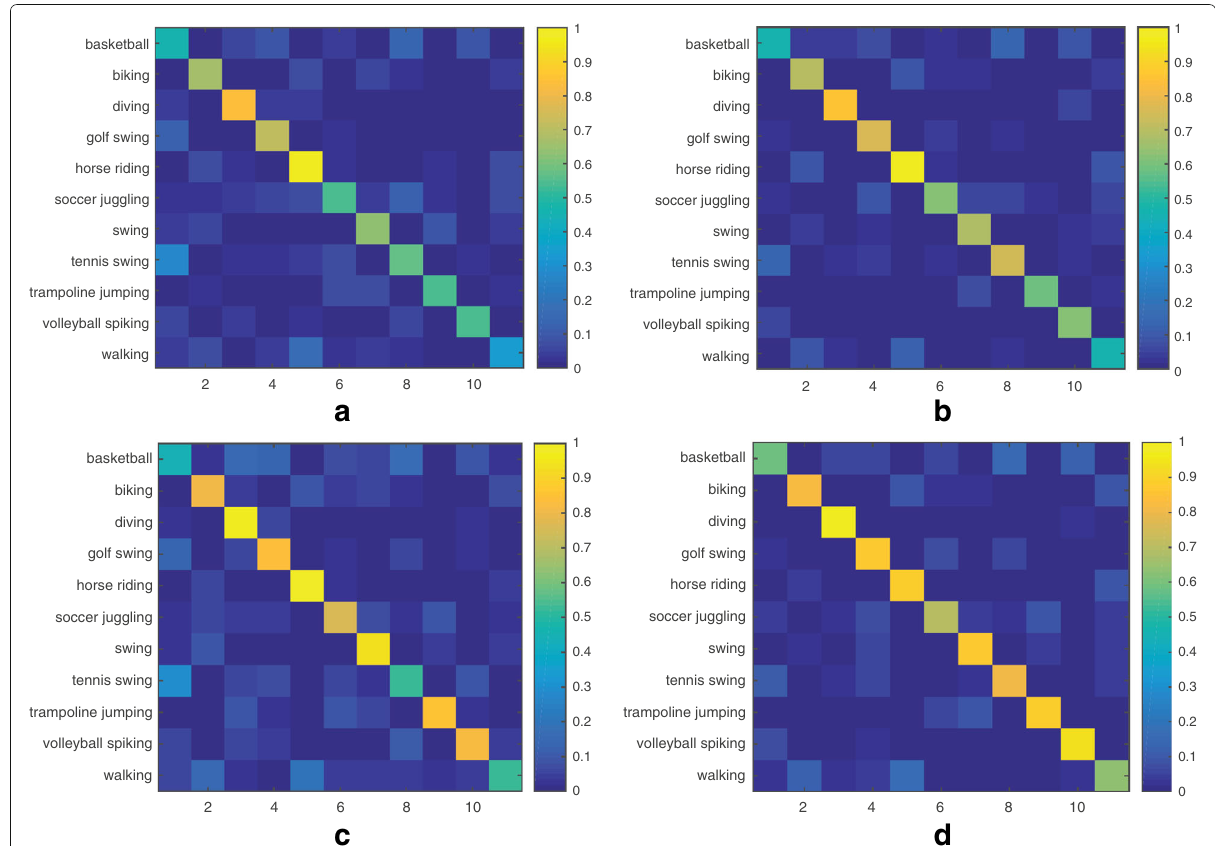
Fig. 9 Confusion matrices of the YouTube-LQ dataset. Confusion matrices on the right side show the effects of fusing BSIF-TOP textural features with STIP and iDT features. a STIP. b STIP+BSIF-TOP. c iDT. d iDT+BSIF-TOP